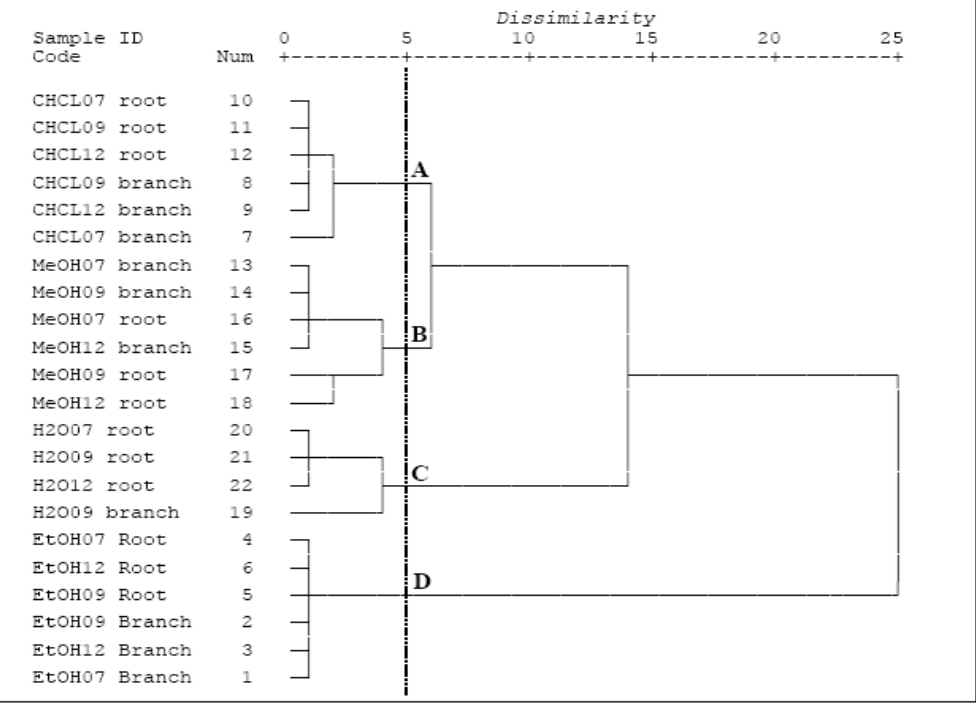
Figure 6. Dendrogram of cluster analysis on different mode of extraction E. longifolia